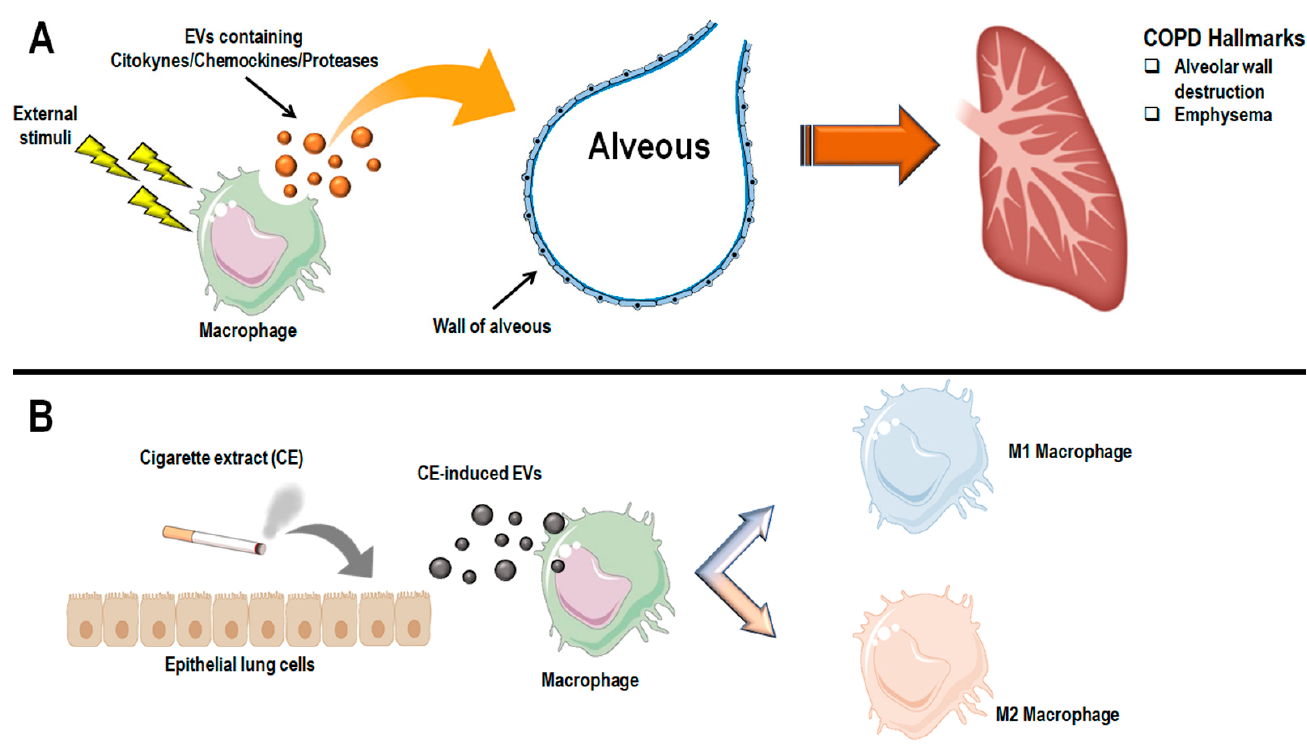
Figure 4. Macrophages are both producers and targets of extracellular vesicles (EVs). ( A ) Macrophage-derived EVs can contain inflammatory effector molecules (e.g., cytokines, chemokines, adhesion molecules, and proteases), which are involved in pathological hallmarks of COPD, such as alveolar wall destruction and emphysema [7,96,100,101]; ( B ) macrophages could also be the target of EVs. Emerging evidence shows that lung cells upon stimulation (e.g., cigarette extract) secrete EVs that target macrophages, influencing their polarization status and function [103–105,107].